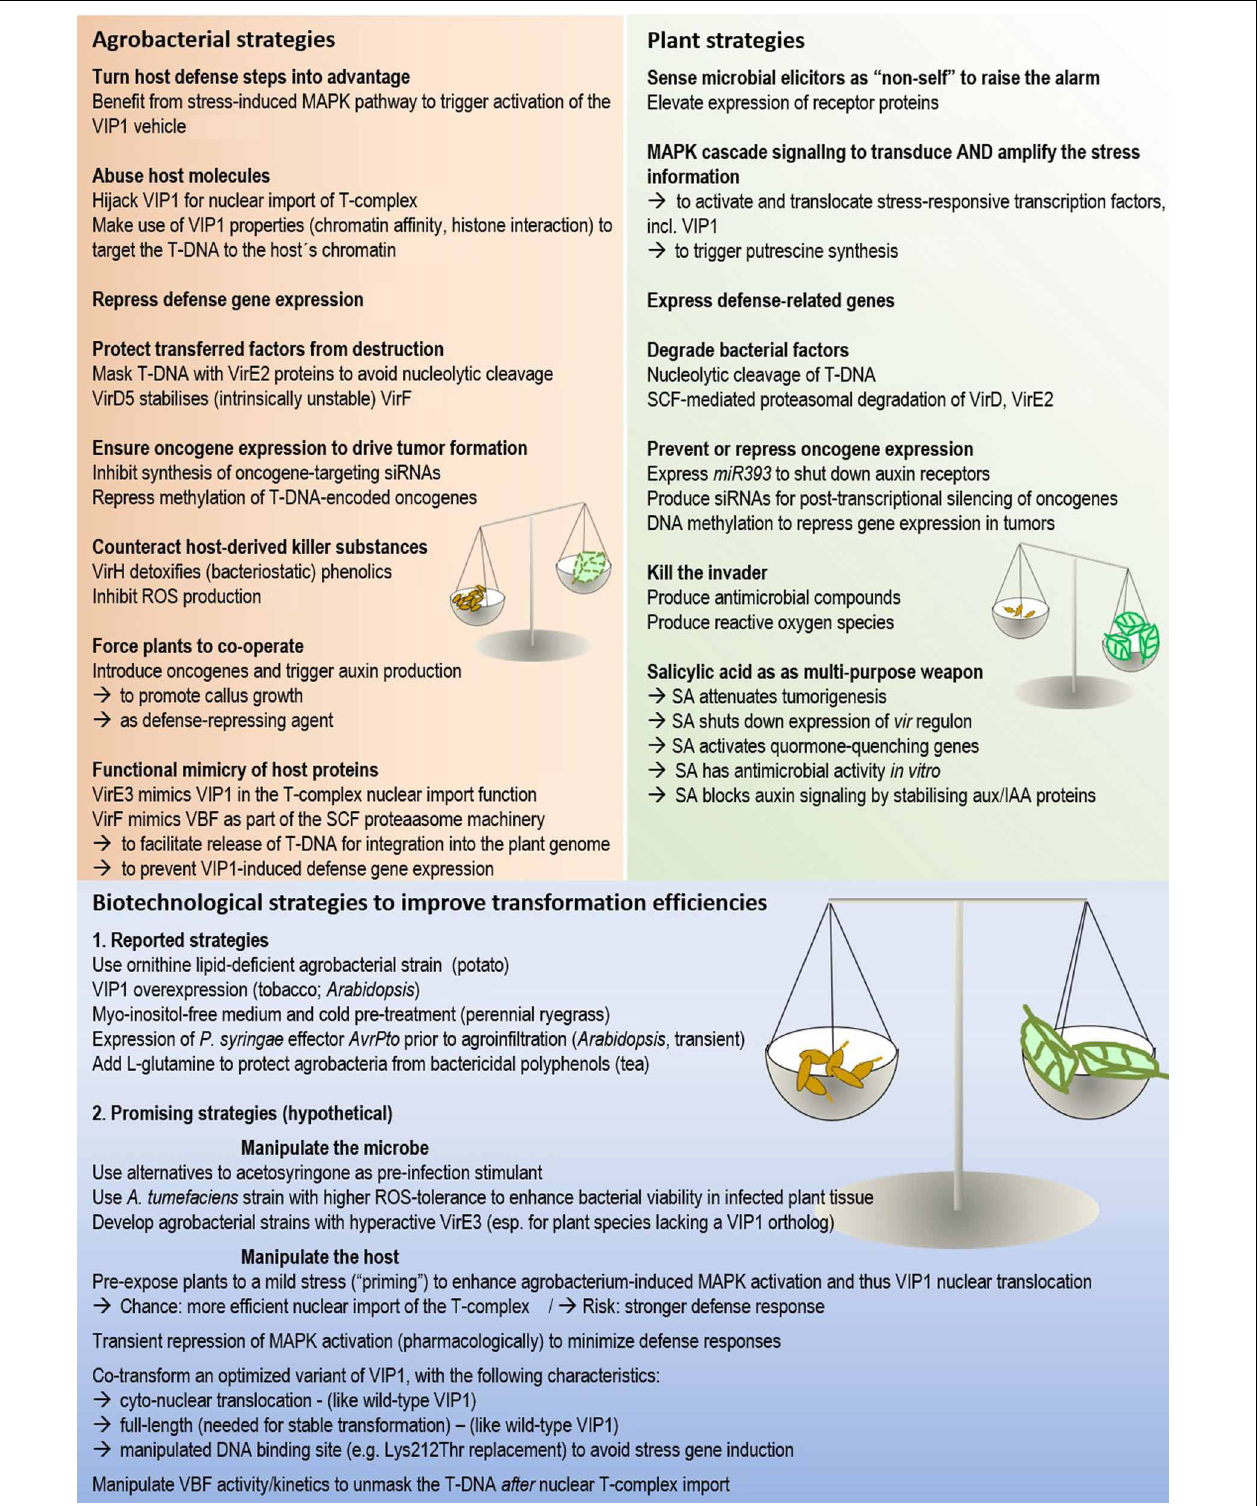
FIGURE 2 | The molecular arms race between host and microbe in Agrobacterium-mediated plant transformation. The activities of both partners need to be well-balanced for successful transformation. Numbers in brackets refer to the corresponding sections in the manuscript.